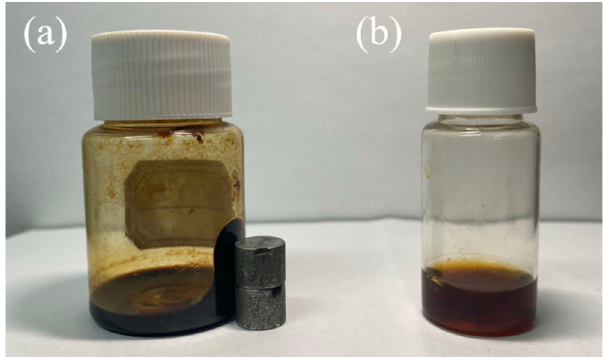
Figure 1. ( a ) Black-brown suspension, composed of Fe 3 O 4 magnetic nanoparticles and ( b ) the solution of Fe 3 O 4 nanosheets.